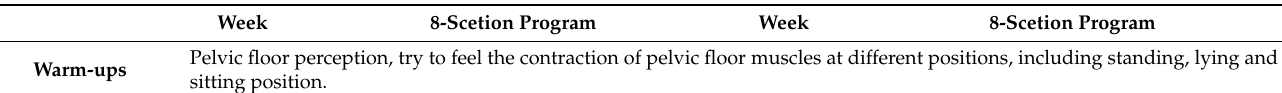
Main Progressive